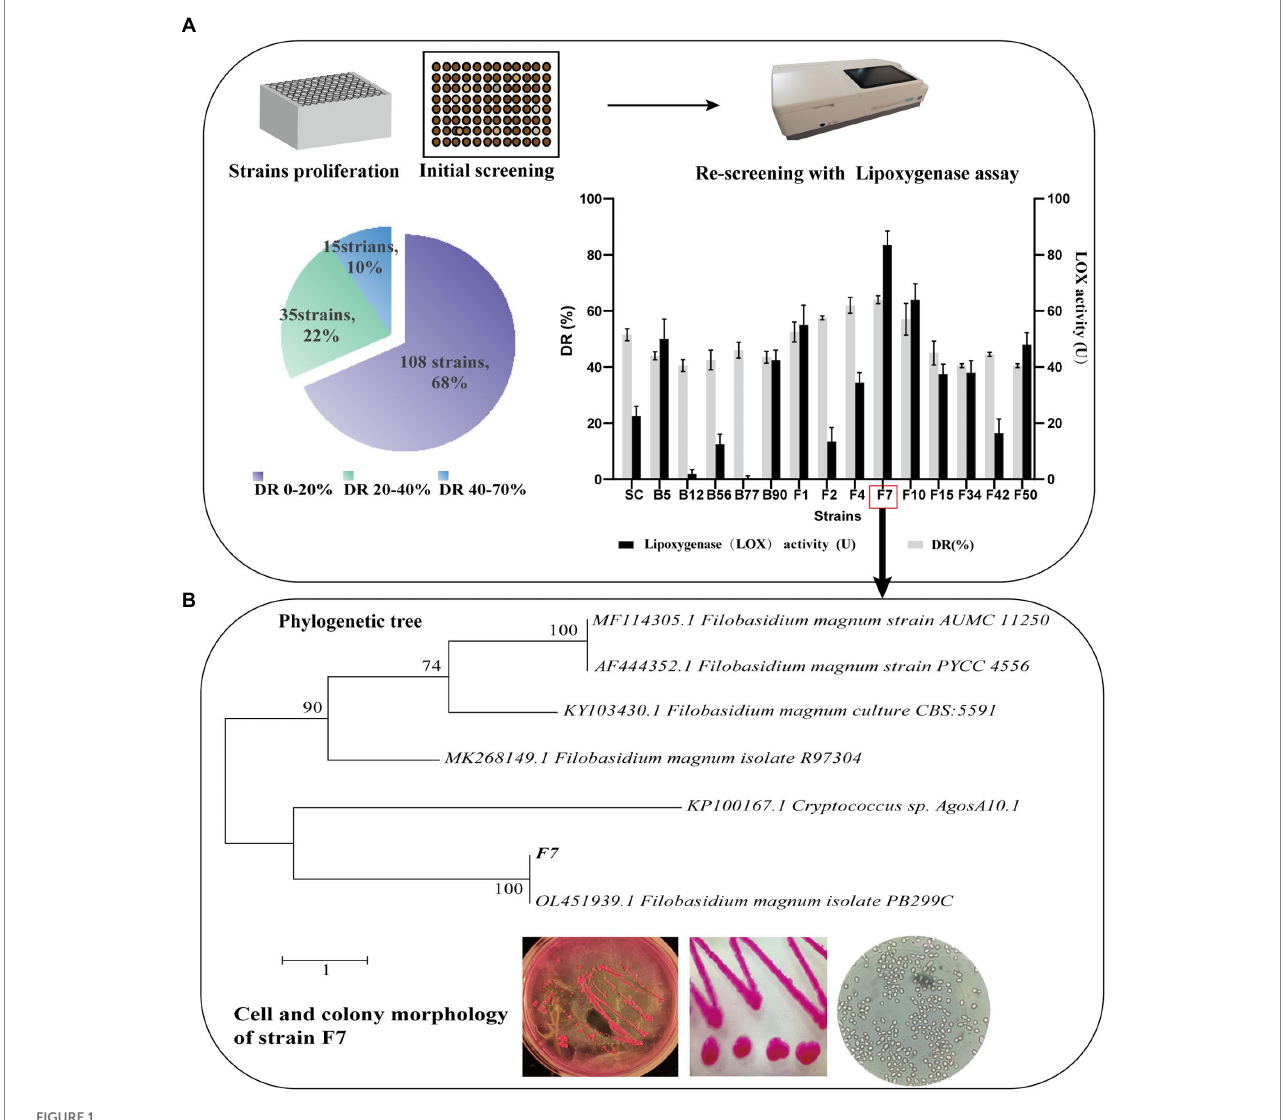
FIGURE 1 Screening (A) and identification (B) of functional